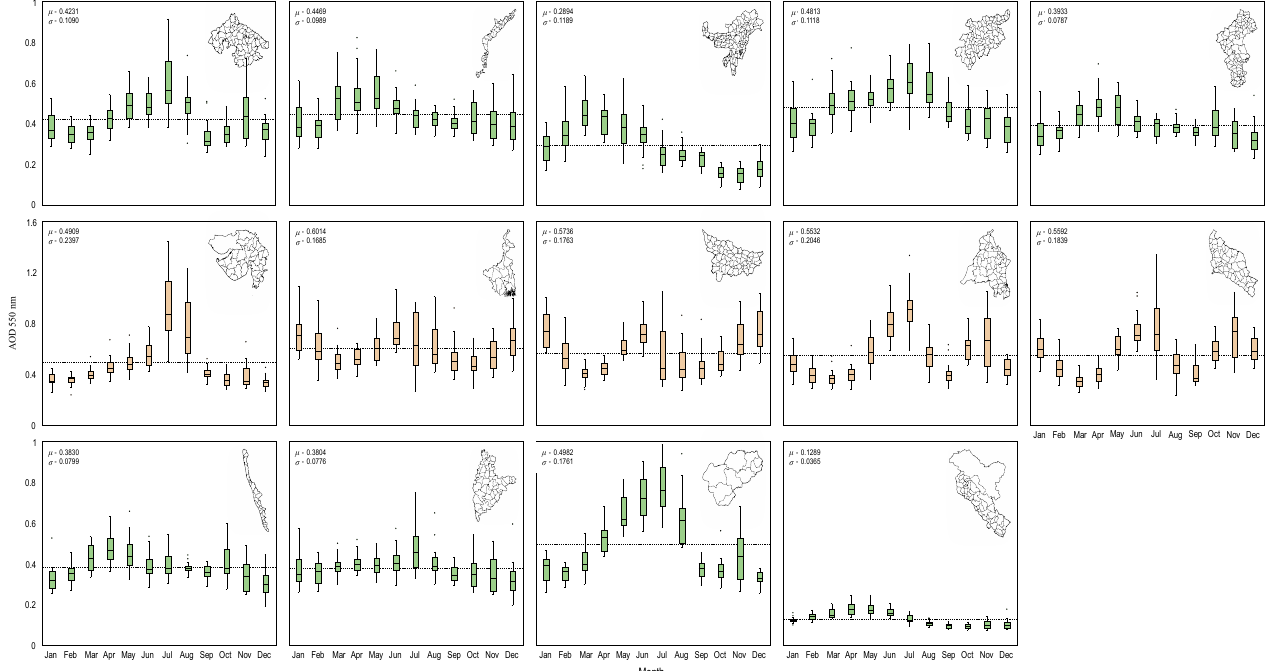
Figure 2. Climatology of monthly mean AOD MODIS for the ecological zones of India isolated for 2001–2020. The green plots represent the agroecological zones with AOD ≤ 1, and the red plots represent the region with AOD ≥ 1. The horizontal dashed line designates the overall mean. µ and σ signify the seasonal mean and SD,